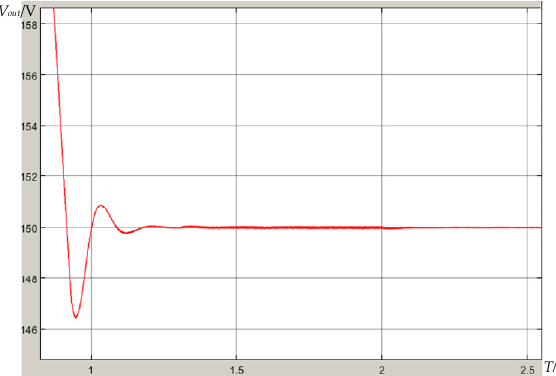
Figure 9. Current through high gain converter inductors.